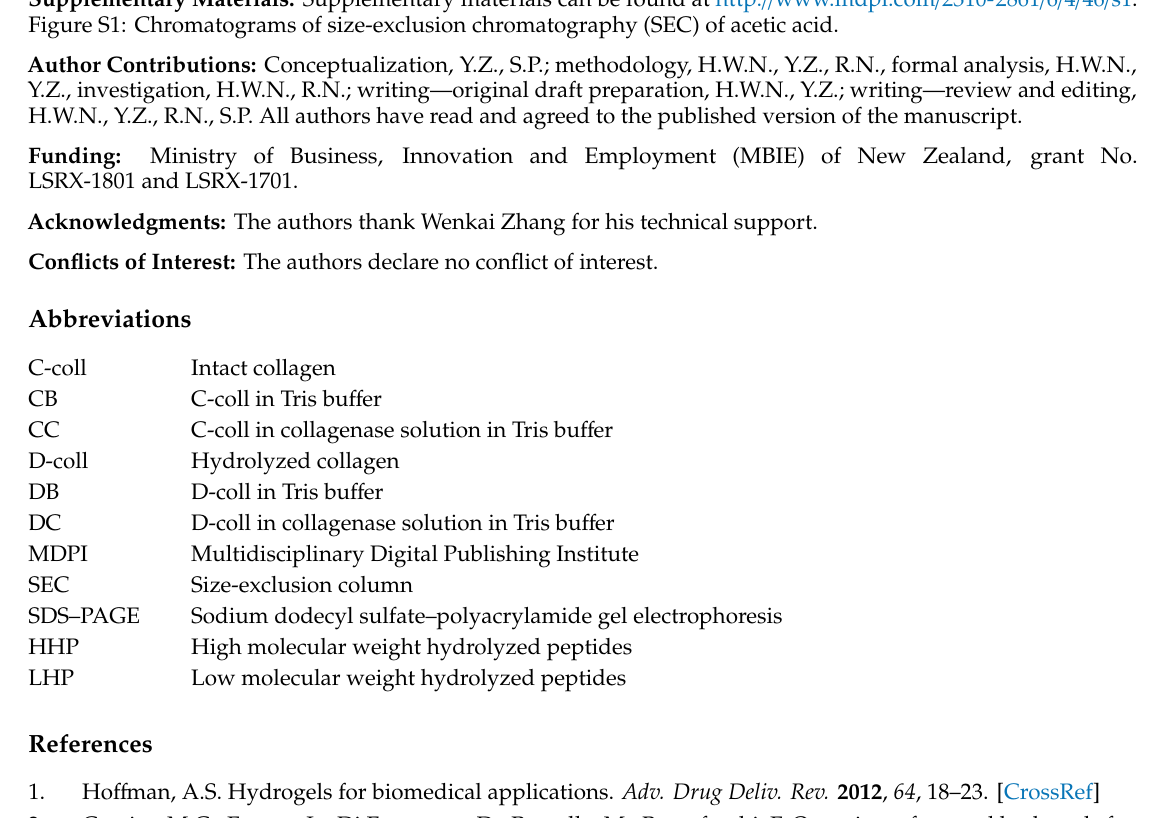
Figure S1: Chromatograms of size-exclusion chromatography (SEC) of acetic